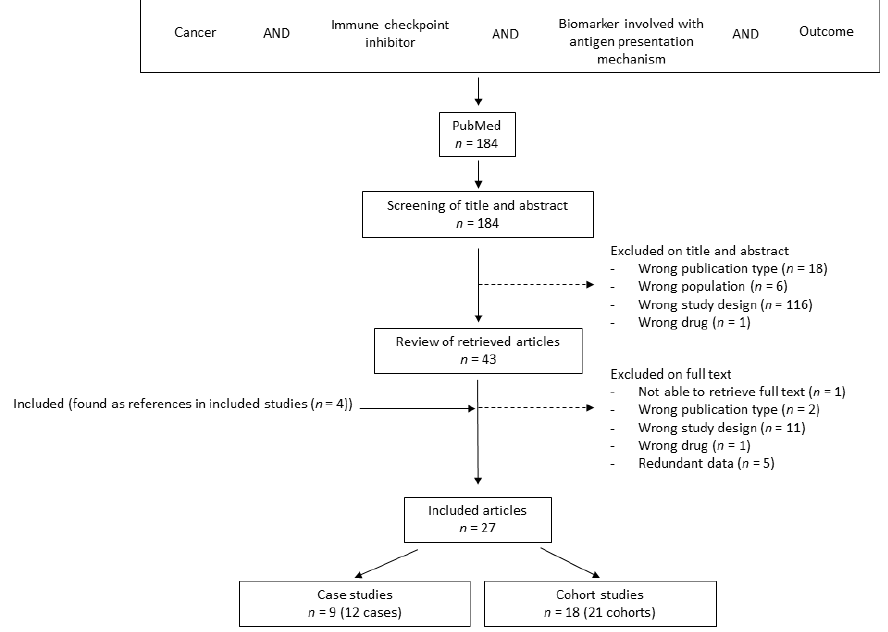
Figure 2. Flowchart depicting the inclusion, screening, and exclusion process of relevant studies. Wrong population included hematologic malignancies, while wrong study design included animal studies, cell line studies, no treatment, no relevant biomarker included, or no relation between biomarker data and response to ICI